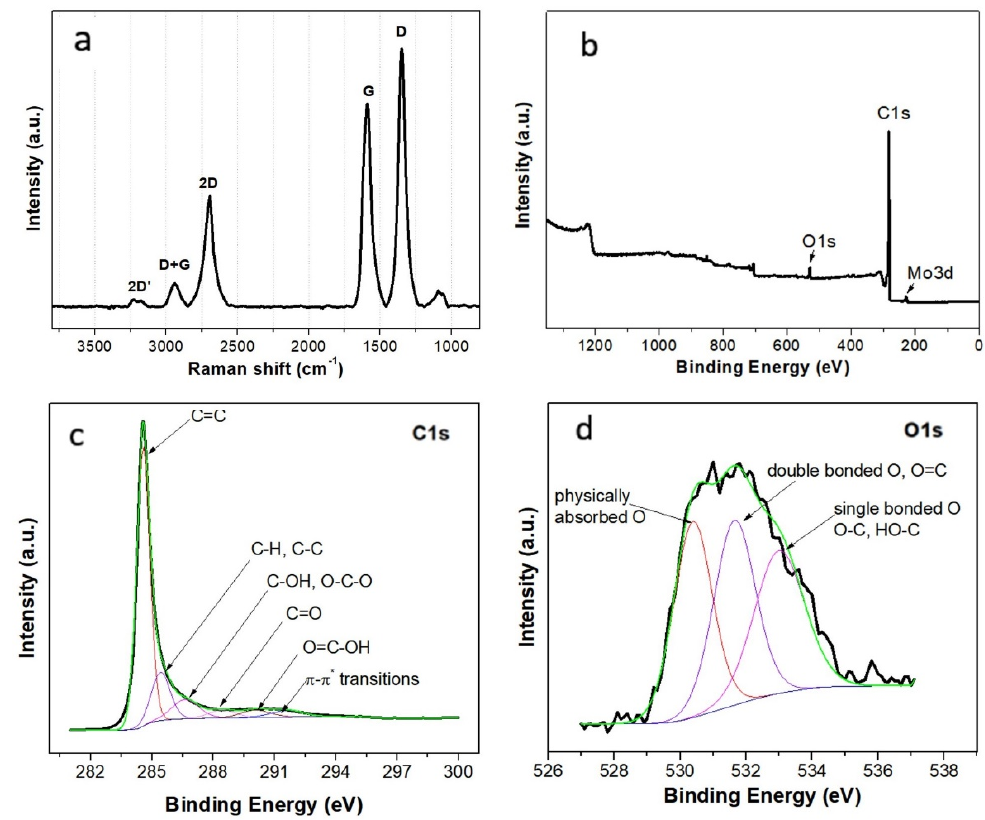
Figure 4. ( a ) Raman spectra of CNWs; ( b ) XPS survey mode presenting the main components of the CNWs; ( c ) primary C1s envelope and ( d ) O1s envelopes of minor constituents with their deconvoluted main components.